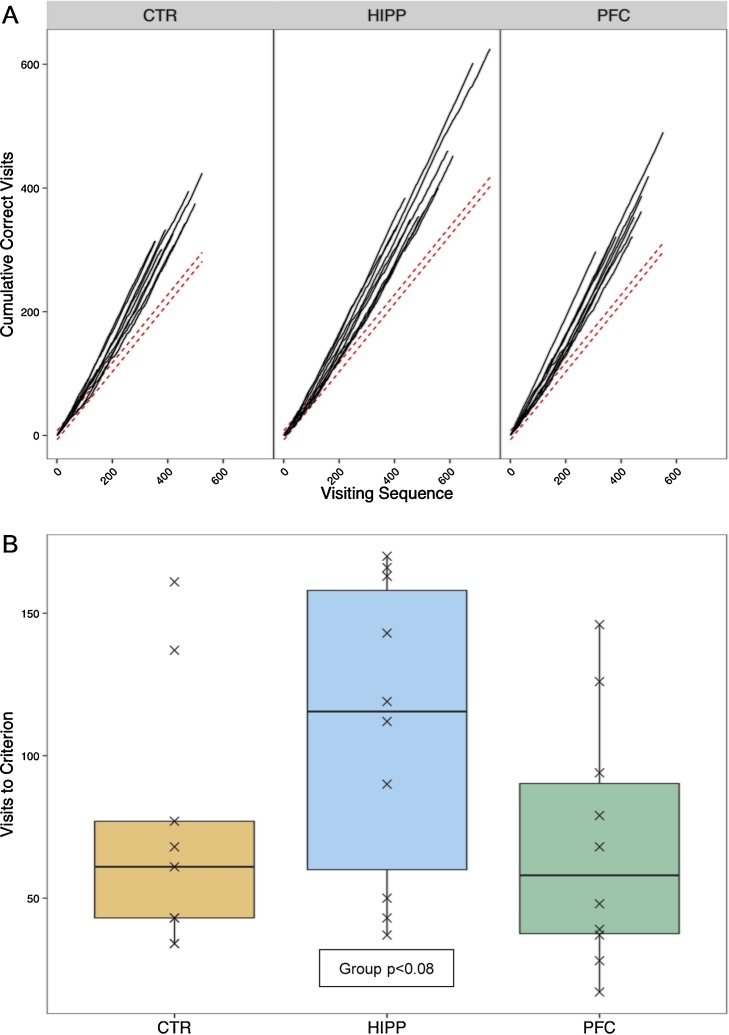
Learning to discriminate the punished from the non-punished side in a corner as evidenced by correctly placing first nosepoke per visit at the rewarded side. This SideAvoid task is mastered by all Les1 mice subjected to it (see Fig. 2). A) Learning plots when one side in each corner responded with an airpuff at nosepoke, the other with giving access to water. Learning boundaries indicated by dotted lines. B) Number of visits to reach preference criterion which appears to be slightly but insignificantly increased in HIPP mice (see text). Note that in two corners left sides were punished, in the two others the right side, when left/right patterns differed between animals.